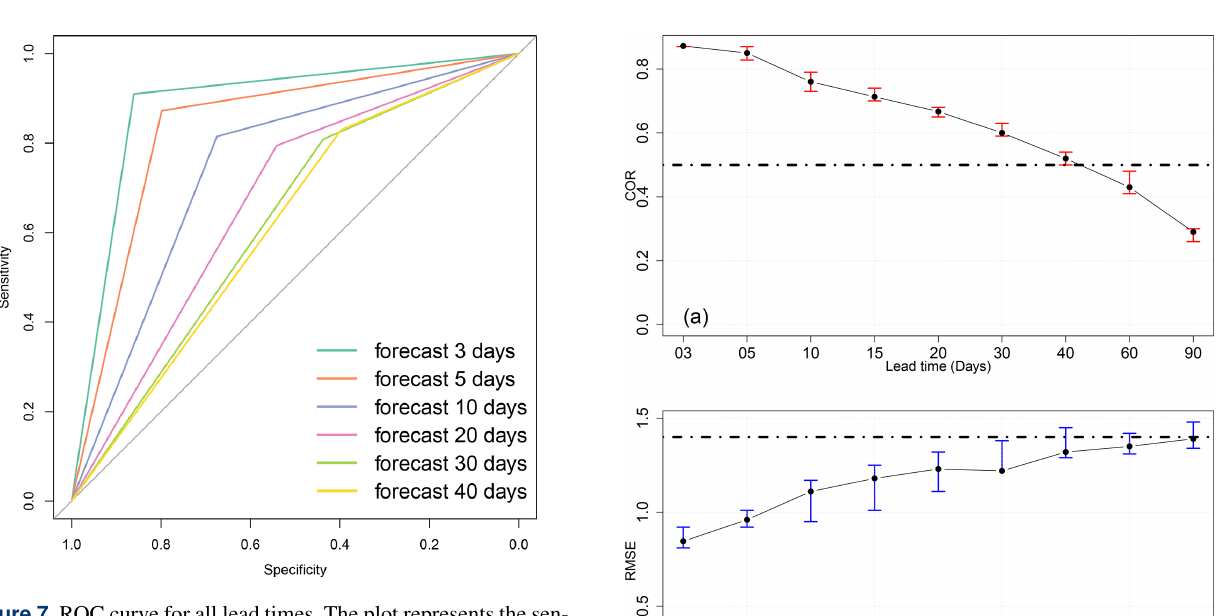
Figure 7. ROC curve for all lead times. The plot represents the sen- sitivity versus the specificity. The diagonal line represents the ran- dom classifier obtained when the forecast has no skill. If the ROC curve is below the diagonal line, then the forecast has a poor skill, otherwise it has a good skill; i.e., the forecast has the potential to distinguish between success and false alarms.